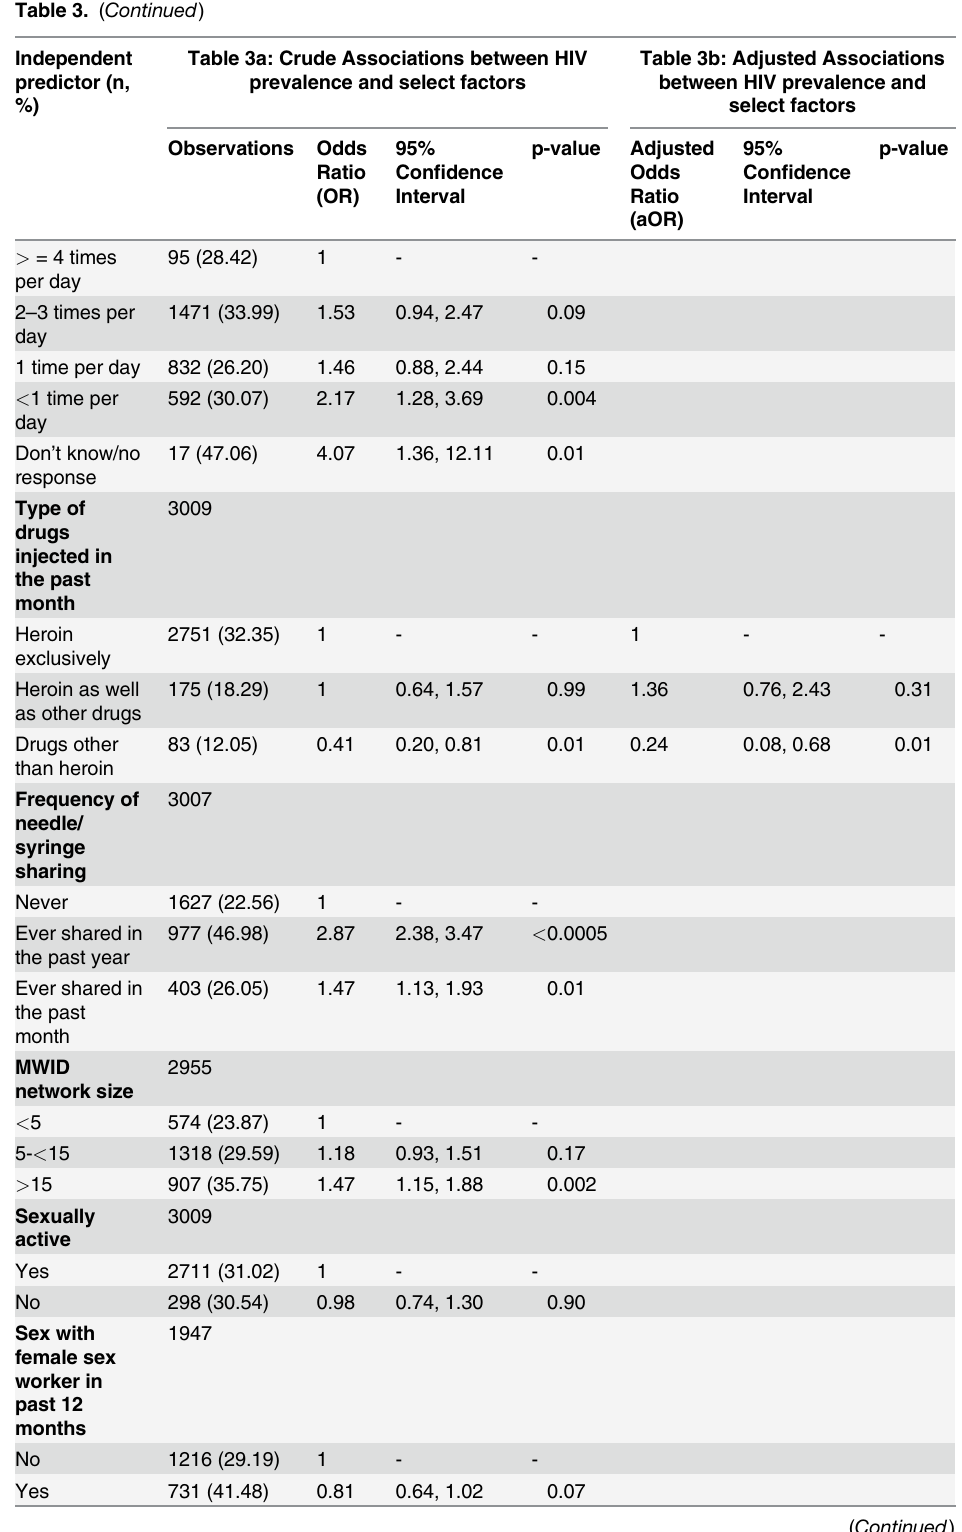
Table 3b: Adjusted Associations between HIV prevalence